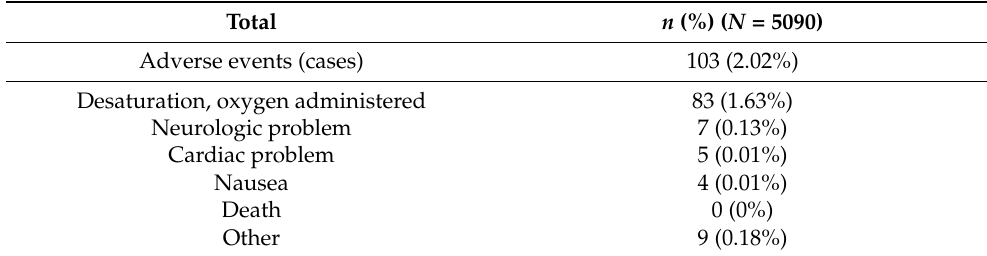
Table 9. Type of adverse event which occurred during sedation by